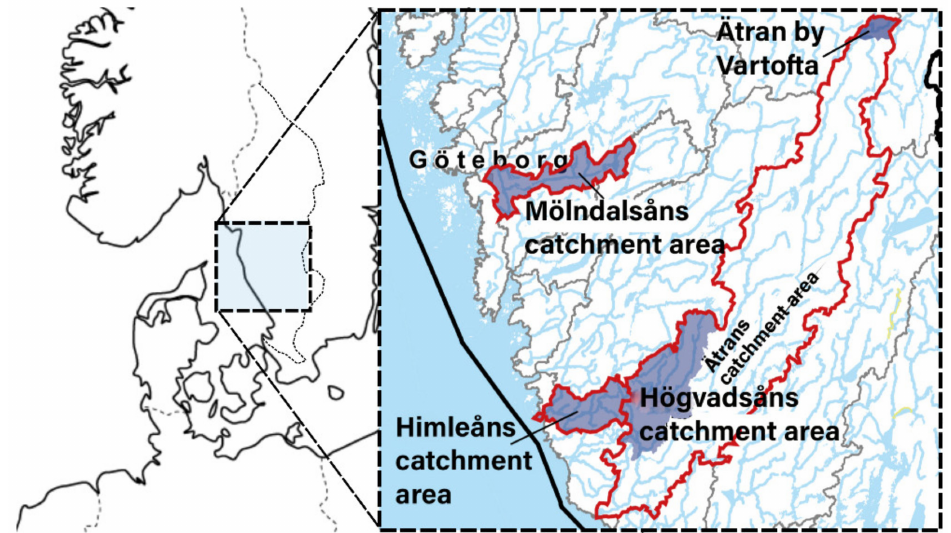
Figure 2. The four pilot projects in three WCs in Skagerrak and Kattegat Water District, Sweden, involved in the WaterCoG project. Source: [48]. © County Administrative Board, SMHI, Swedish Survey; Diary no. 106-2004/188. Permission obtained from